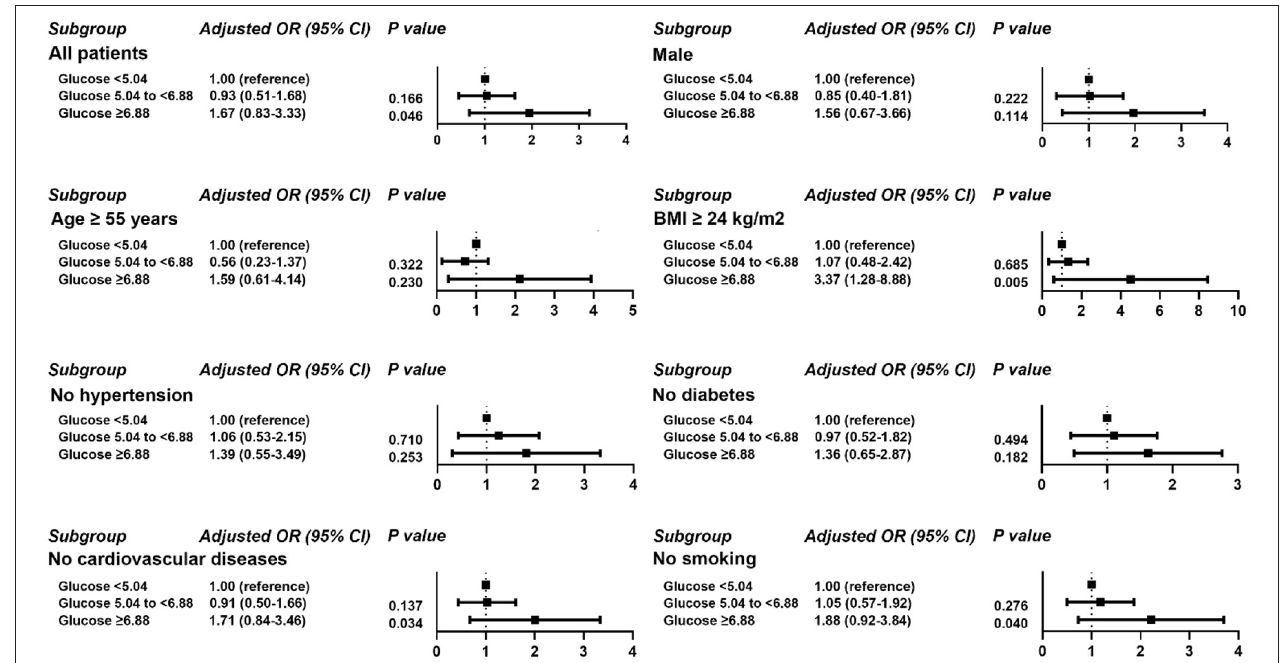
FIGURE 2 | Results of subgroup analyses of POBG and a hospital length of stay > 2 weeks based on clinical characteristics.